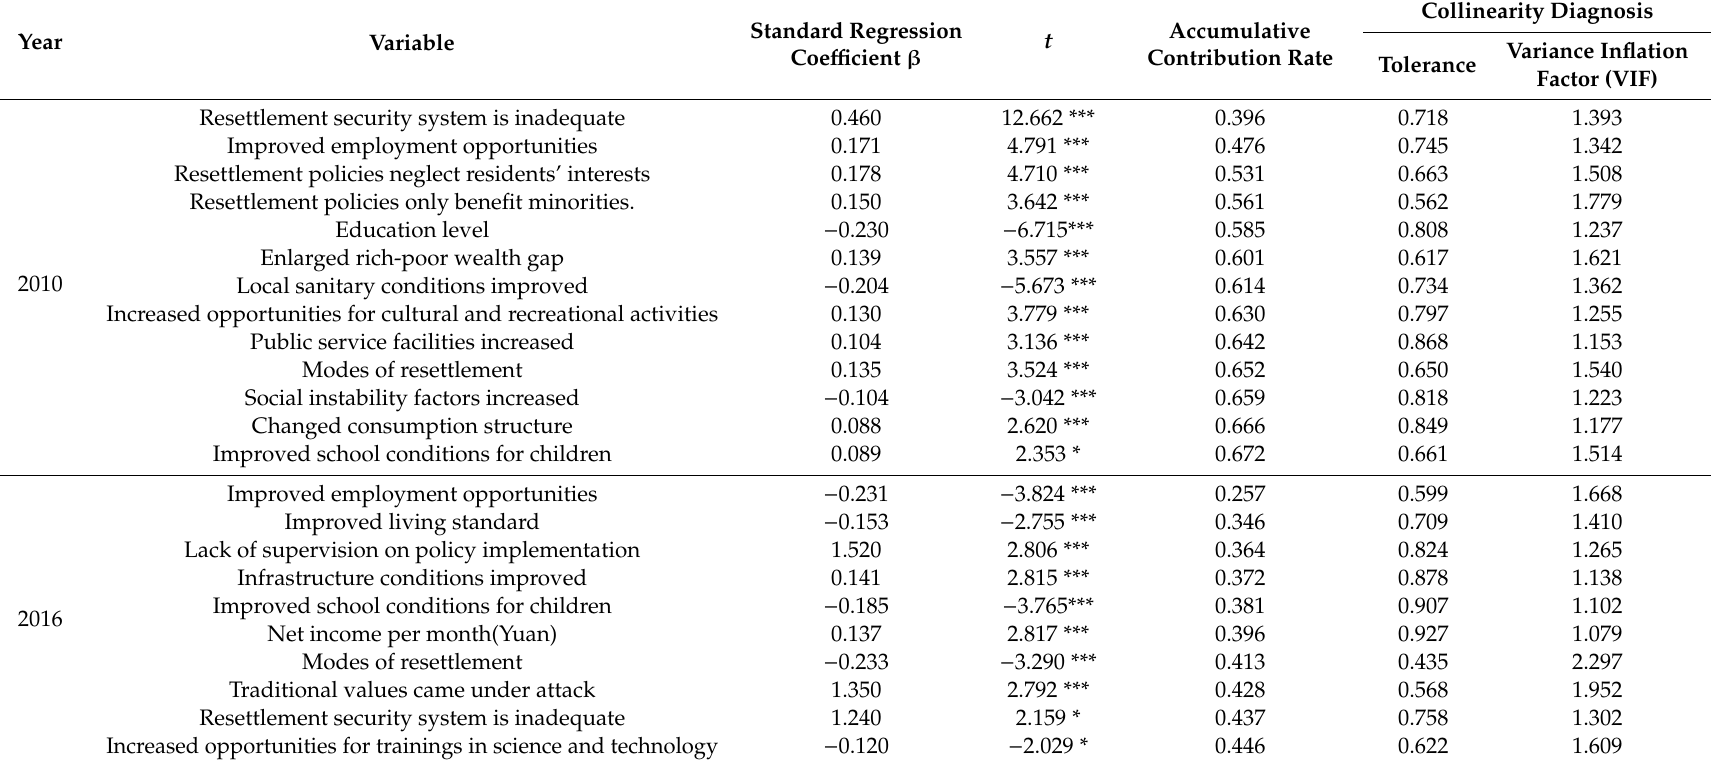
Table 4. Stepwise multiple regressions analysis of residents’ overall